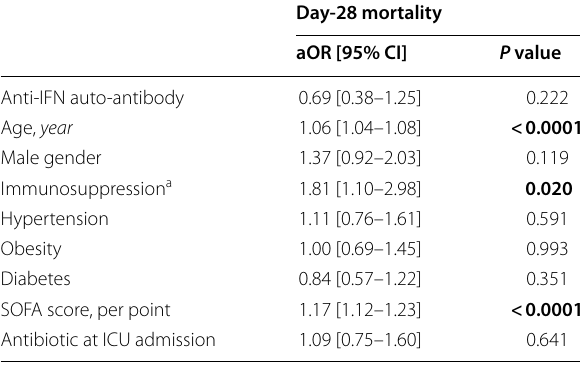
Table 3 Multivariable logistic regression analysis of factors associated with mortality at 28 days in patients with severe SARS‑ CoV‑2 infection ( n 852) =